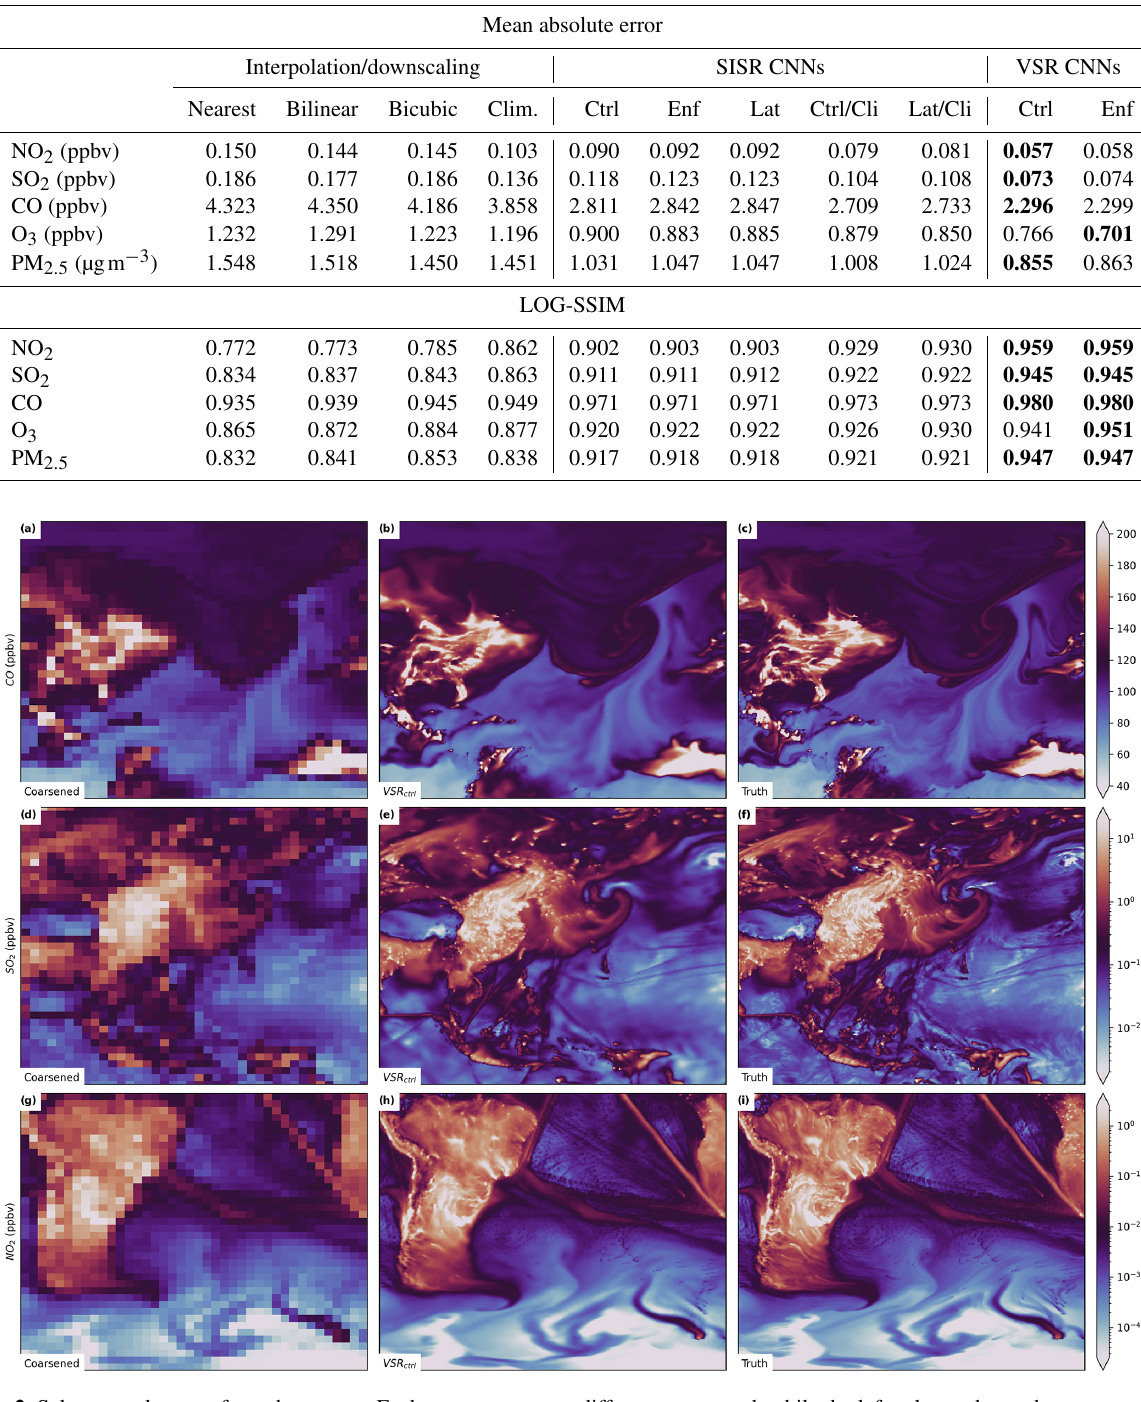
Figure 2. Select sample cases from the test set. Each row represents a different compound, while the left column shows the coarsened data, the middle column shows the super-resolved output from the best-performing CNN for that compound, and the right column shows the ground